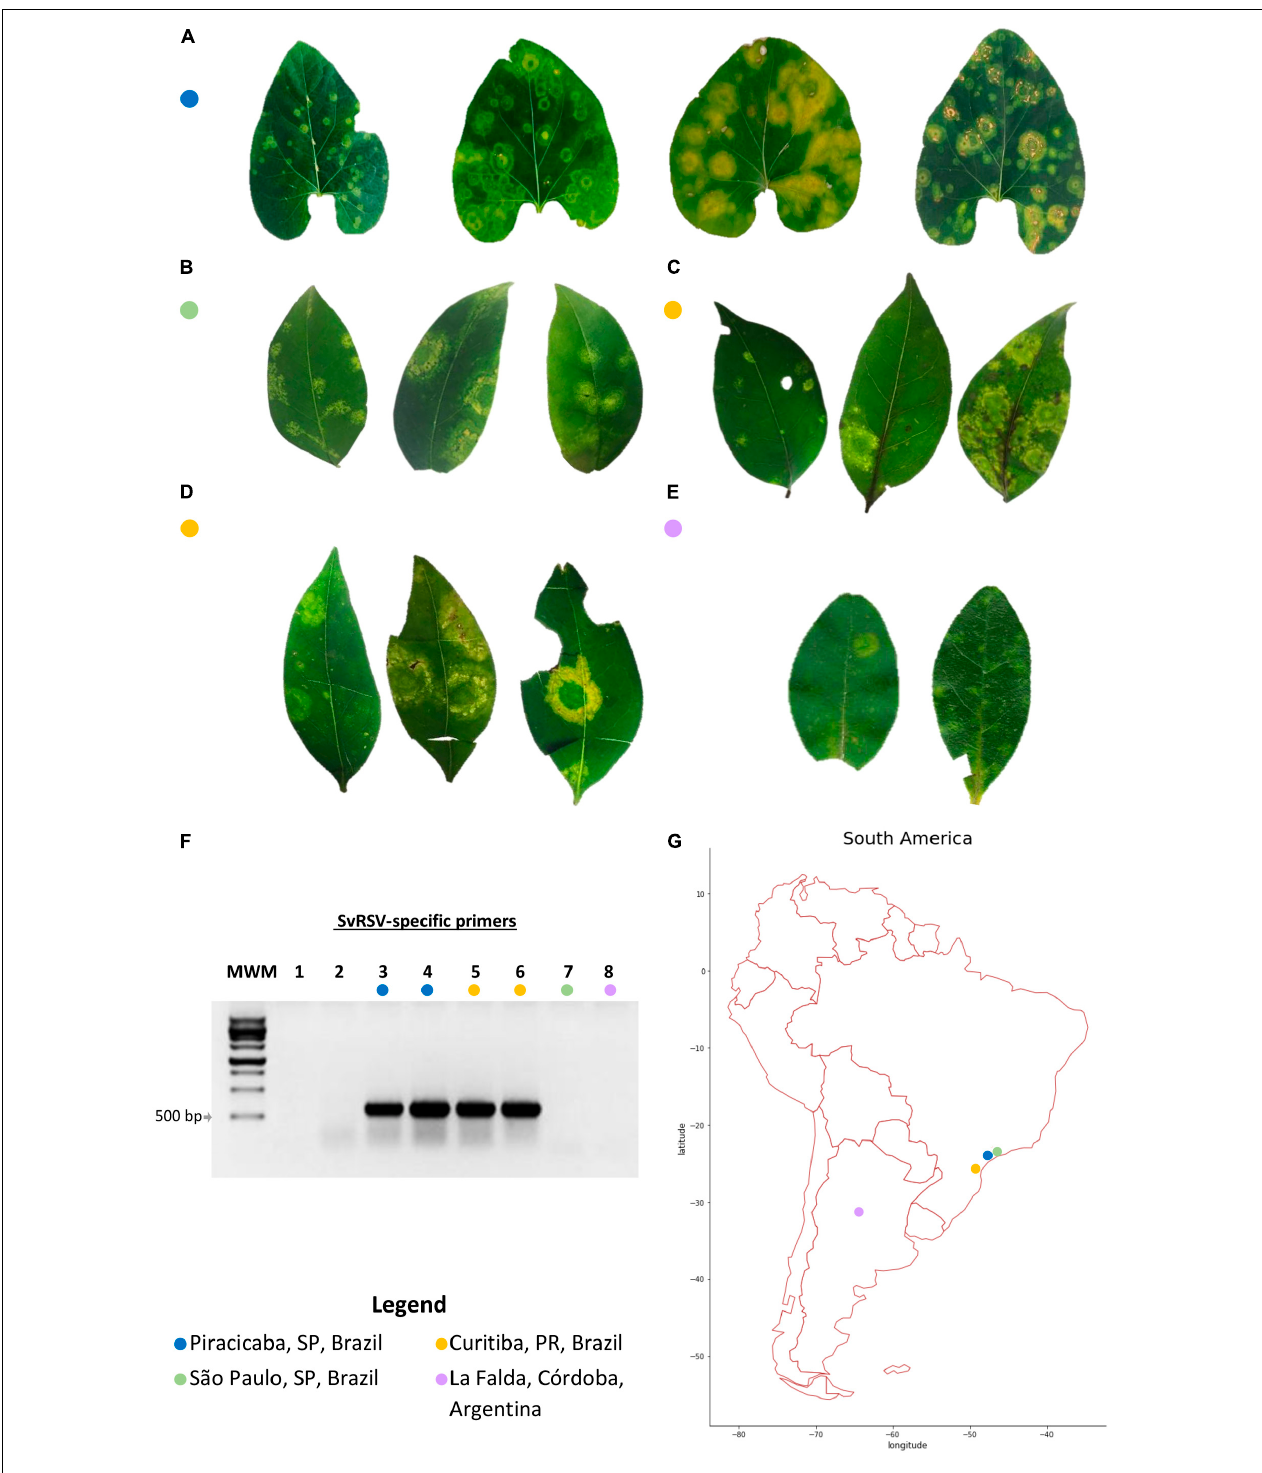
FIGURE 1 | Leaf symptoms, detection of the partially characterized Solanum violifolium ringspot virus (SvRSV) in the RNA extracts, and place of collection of the samples. (A) Sample Prb1. Leaves of the ornamental herbaceous Solanum violifolium plant were likely collected during different stages of disease progression. The leaf on the left shows small chlorotic ring spots and was likely collected a few days after the infection. In contrast, the three leaves on the right show large chlorotic spots that also include necrotic areas in form of concentric circles. (B) Sample SPa1. Leaves of the ornamental shrub Ligustrum japonicum , collected in a private garden, show chlorotic spots with yellow irregular lesions, and regular concentric rings. (C) Sample Crb1. Leaves of L. lucidum were collected in the public garden Bosque do Papa in the city of Curitiba, PR, showing yellow concentric spots of variable sizes. (D) Sample Crb2. Leaves of L. japonicum plants were collected in